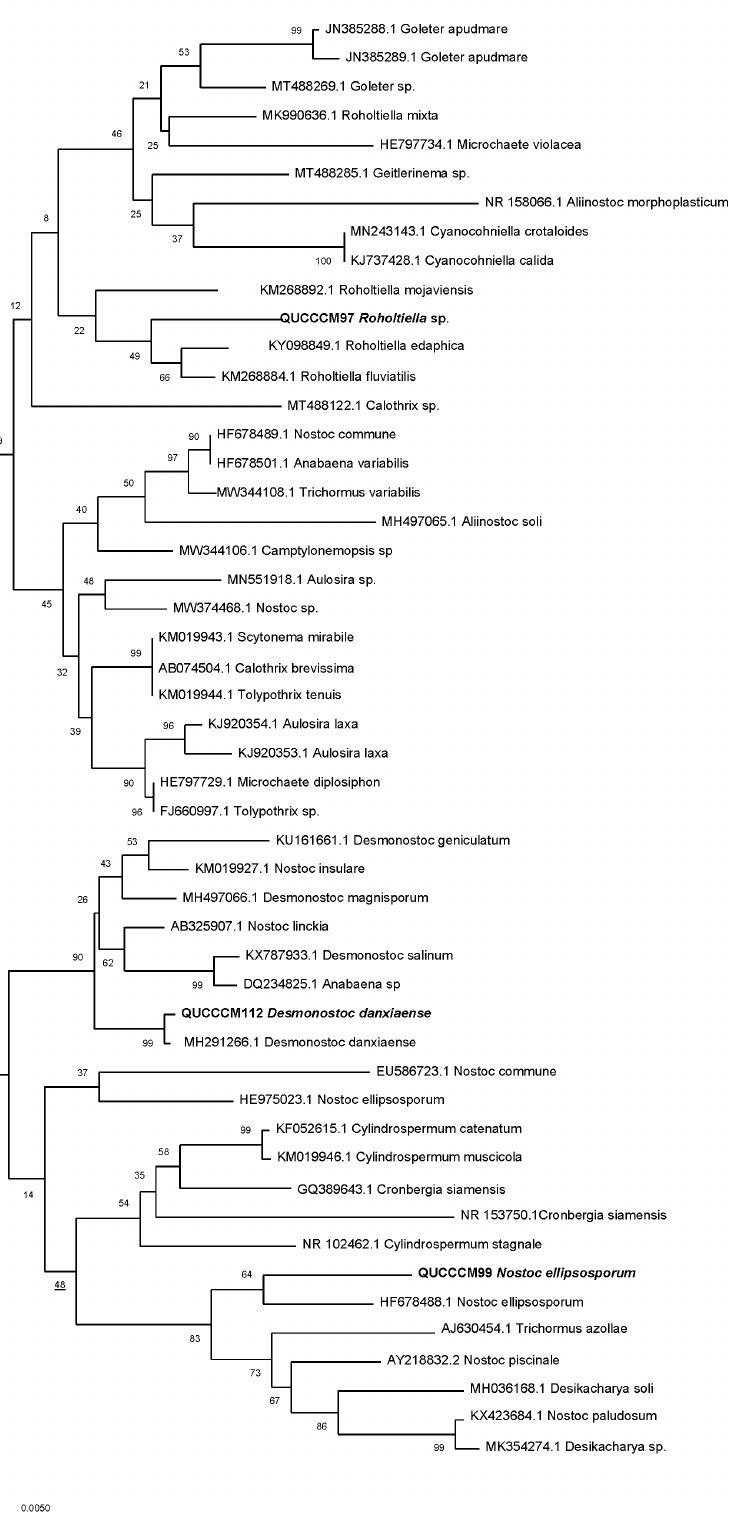
Figure 4. (a) Phylogenetic tree based on neighbor-joining method using MEGA X software. The percentage of replicate trees in which the associated taxa clustered together in the bootstrap test (1000 replicates) are shown next to the branches.